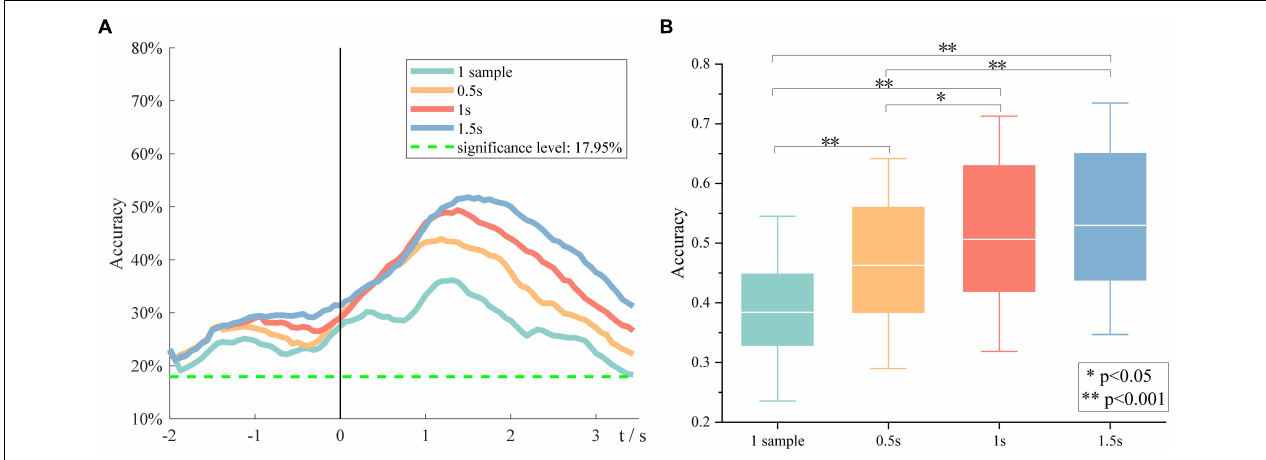
FIGURE 7 | The impact of window size on the overall performance. (A) Grand average accuracies of using four window sizes. (B) The peak accuracies of all subjects obtained using four window sizes.